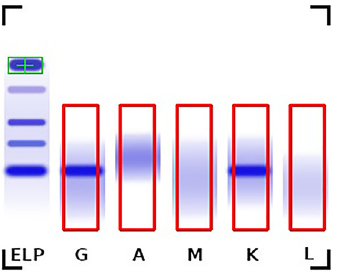
Figure 1: Example immunofixation image with the serum albumin reference position (green) and the bounding boxes of the individual lanes (red) shows a monoclonal gammopathy IgG type Kappa.